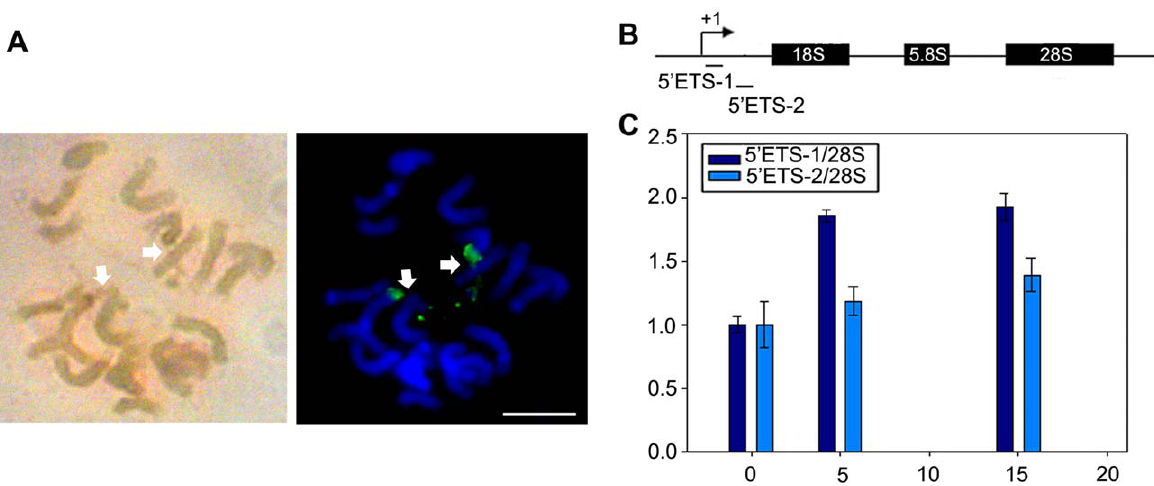
Figure 4. Effects of ActD on rRNA transcription in maize. (A) Co-localization of Ag-NOR proteins (left) and NOR site extension (right) in maize metaphase chromosomes after treatment with 15 m g/ml ActD. Arrows indicated extended NORs. Bar=5 m m. (B) Schematic representation of the maize rRNA genes and the primers for quantitative analysis. (C) Quantitative real-time PCR analysis of 5 9 ETS transcripts in maize after treatment without or with 5 m g/ml and 15 m g/ml ActD, respectively. ActD treatment accumulated incomplete 5 9 ETS transcripts in maize. The y-axis indicated relative expression values and the x-axis indicated the various concentrations of ActD. Expression values were normalized to the levels of 28S rRNA. Relative expression ratio of each sample was compared to the maize root without ActD treatment which was assigned to the value of 1. Each experiment was repeated three times and the average value was shown with the SD.